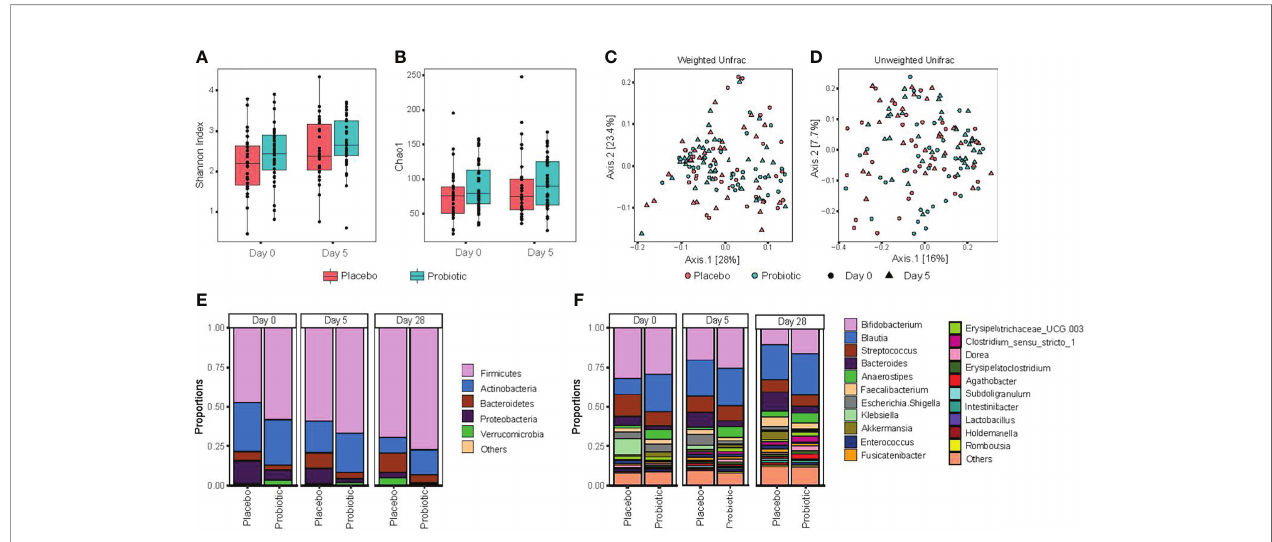
FIGURE 2 | Probiotic treatment does not signi fi cantly alter gut microbiota composition or diversity. Stool samples were collected at the time of acute enteritis and entry into the study (day 0), 5 days after either probiotic or placebo (day 5) and 28 days following entry into the study (day 28). (A) alpha diversity, as measured by Shannon index; (B) alpha diversity species richness metric Chao1; (C) principal coordinate analysis of beta diversity, measured by Weighted Unifrac distances; (D) principal coordinate analysis assessed by unweighted Unifrac distances. Statistical signi fi cance was assessed using repeated measure (PERMANOVA); (E) relative abundance of gut bacteria characterized at the phylum level; and (F) relative abundance of the top 20 genus level taxa. Signi fi cance was assessed using two- sided permutation t-test, with multiple comparisons corrected by false discovery rate